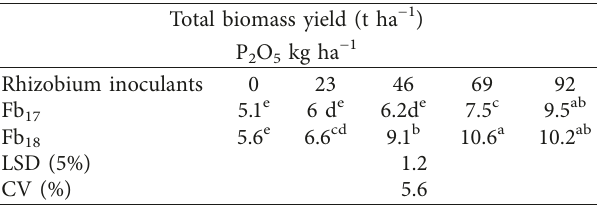
Table 13: Interaction effects of rhizobium inoculation and P fertilizer rate on dry biomass yields.